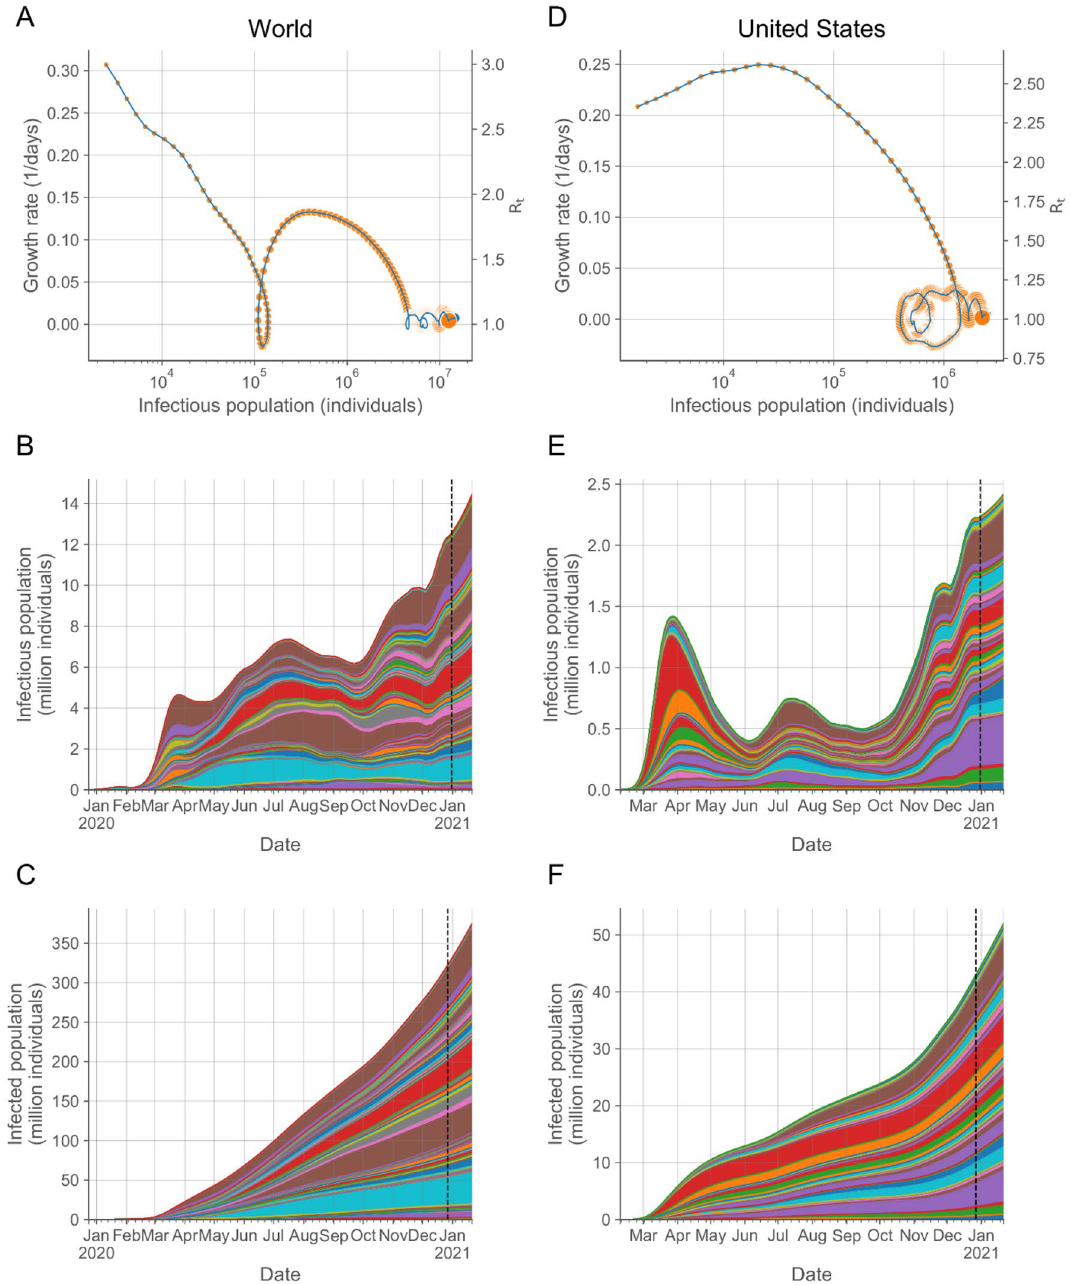
Figure 3. Characterization of the temporal evolution of the COVID-19 outbreak. Trajectory in the growth rate-infectious population space ( A , D ) and infectious ( B , E ) and infected ( C , F ) populations over time of the aggregate values for countries in the world ( A – C ) and locations in the US ( D – F ). In the trajectories ( A , D ), each day is indicated by a symbol increasing in size with time, ending with the largest symbol on December 30, 2020. The blue line at the end indicates the extrapolation to current time (January 21, 2021). The right axes indicate the growth rate in the scale of the reproduction number as R t = 1 + k G ( t )τ G (See “Methods: Reproduction number”). Each colored region in the area plots represents the contribution of a country ( B , C ) or a state ( E , F ) to the overall infectious and infected populations. Countries and states are arranged in alphabetical order from bottom to top. The vertical dashed lines ( B , C , E , F ) indicate the transition from inference to extrapolation. Individual data for all the countries and states are provided in Supplementary Fig.